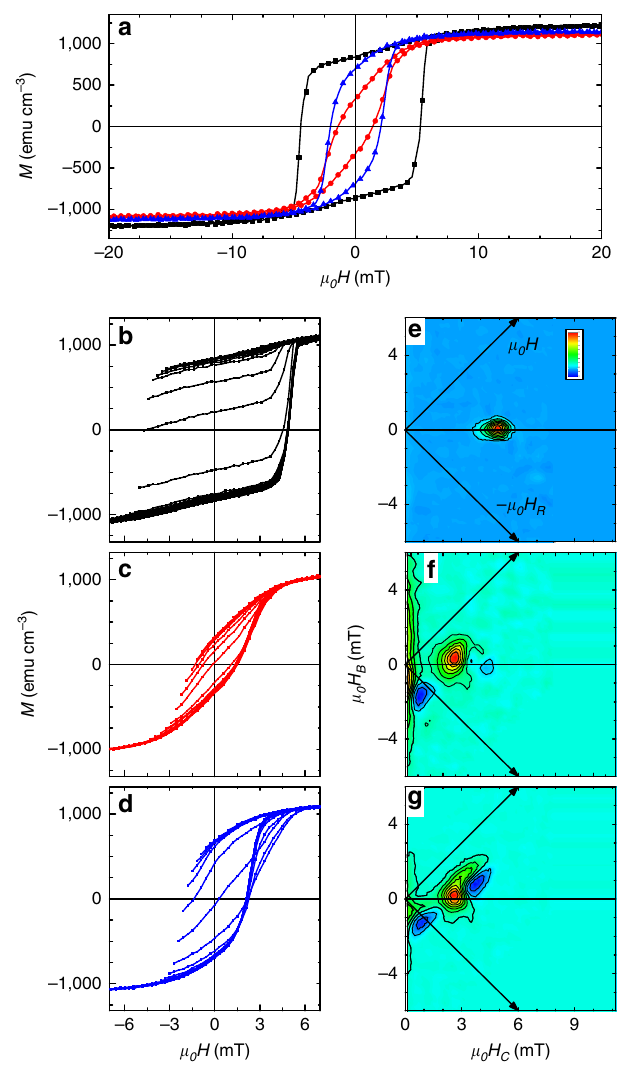
Figure 3 | Magnetometry and FORC investigations. ( a ) Combined major hysteresis loops for the sample (black) as-grown, (red) after þ / (cid:2) 40V conditioning and (blue) after thermal-only conditioning. Family of FORCs and FORC distributions for the sample ( b , e ) as-grown, ( c , f ) after þ / (cid:2) 40V conditioning and ( d , g ) after thermal-only conditioning. Color bar in e identifies the max (red) and min (blue) value of the FORC distribution for the as-grown sample are shown in Fig. 3b and e, respectively. The family of FORCs show the minor loops fill the major loop, and the calculated FORC distribution shows only a single feature, centred at (local coercivity m 0 H C ¼ 4.9 mT, bias field m 0 H B ¼ 0 mT, where m 0 is the vacuum permeability 4 p (cid:3) 10 (cid:2) 7 N A (cid:2) 2 ), indicating the sample is comprised of a